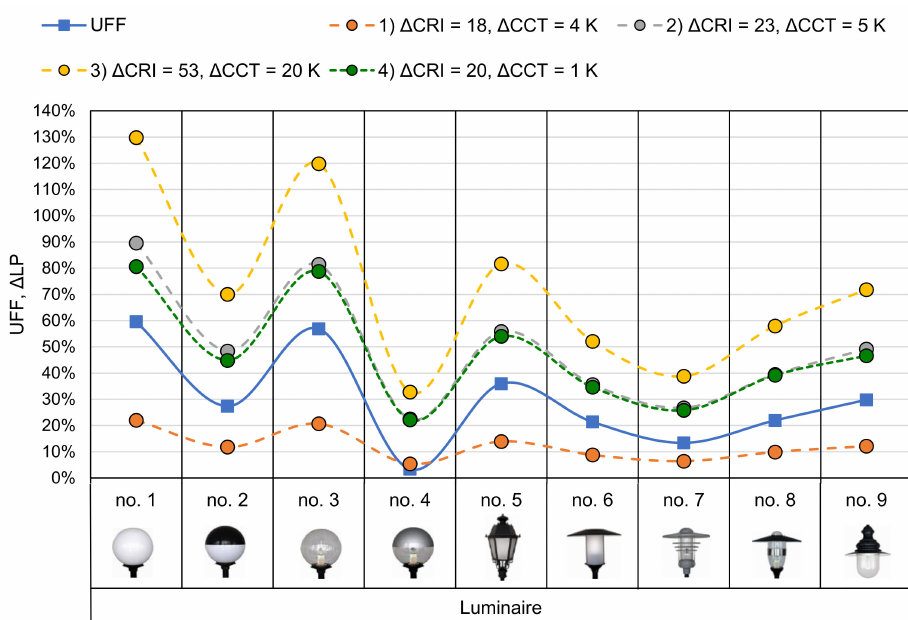
Figure 18. Graphical representation of the UFF factor of nine luminaires and the possibility of reducing the LP effect using the LED sources with similar CCT and different CRI